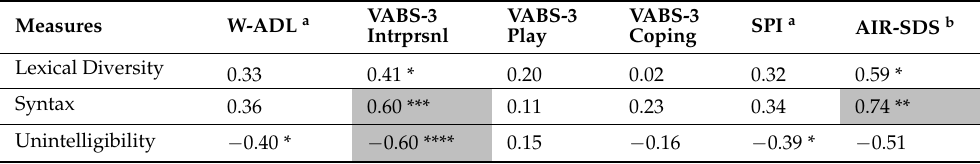
n = 24 unless otherwise noted. Shaded cells are significant at p ≤ 0.050 after FDR correction. * p ≤